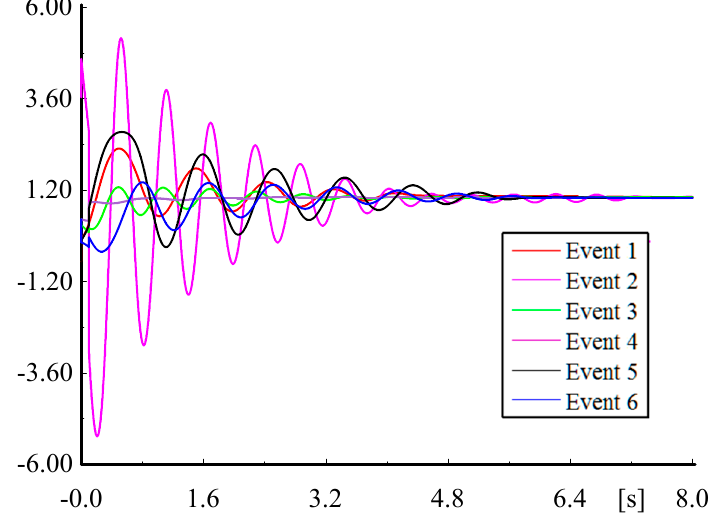
Figure 2. Normalized active power of Line 4–6 per steady-state value after each event.